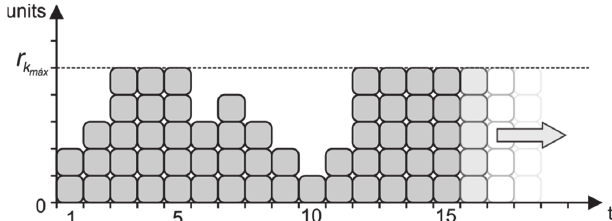
Fig. 2. Concepts of time-slot, resource-unit, resource capacity and resource